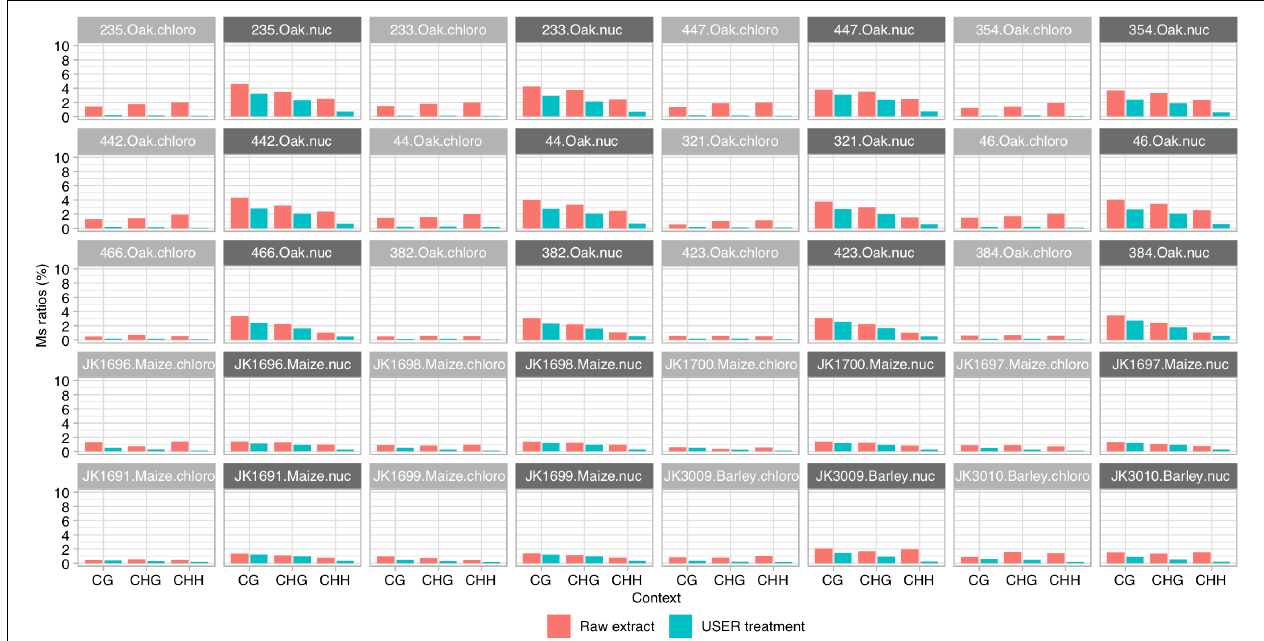
FIGURE 2 | Ms ratios for CG, CHG, and CHH contexts. Results are shown for paired sequence data of USER-treated and raw extracts of ancient oak, maize, and barley samples, for chloroplast and nuclear DNA, respectively. Scores are reported for full read length. For Ms ratios computed for outer and inner read regions, see Supplementary Figure S1